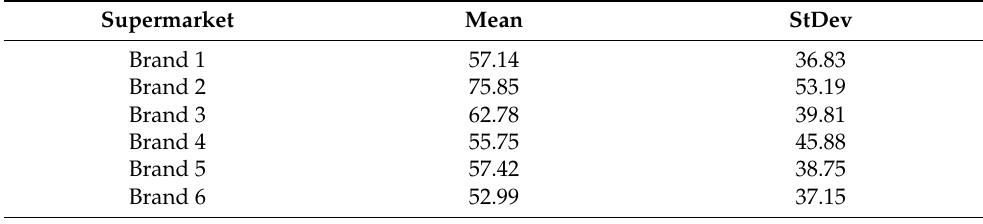
Figure 4. Histogram of supermarket waiting time.